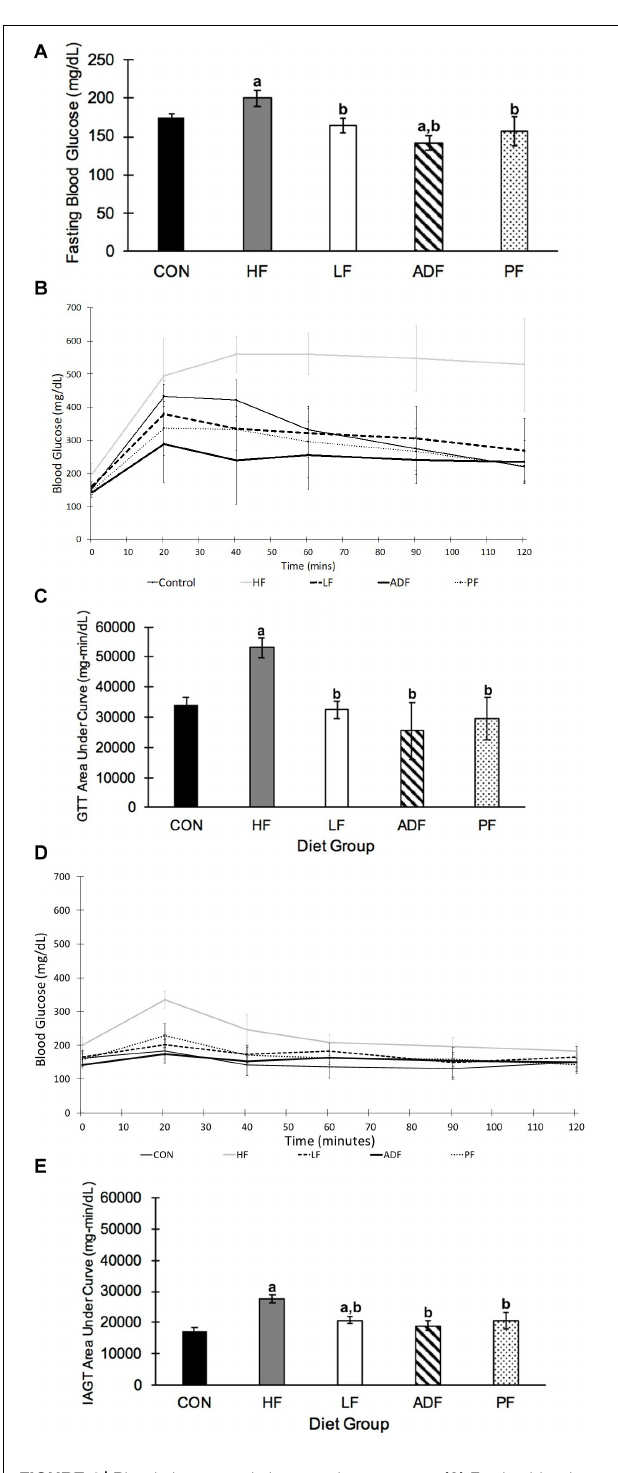
FIGURE 4 | Blood glucose and glucose tolerance tests. (A) Fasting blood glucose. Blood glucose was measured after a 6 h fast, which started at the onset of the light phase. Blood glucose of ADF mice was measured after a fed day. Mice in the HF group had significantly higher fasting blood glucose than all other diet regimens ( p < 0.05). ADF mice had significantly lower blood glucose compared to CON mice (B) Glucose tolerance test. A GTT